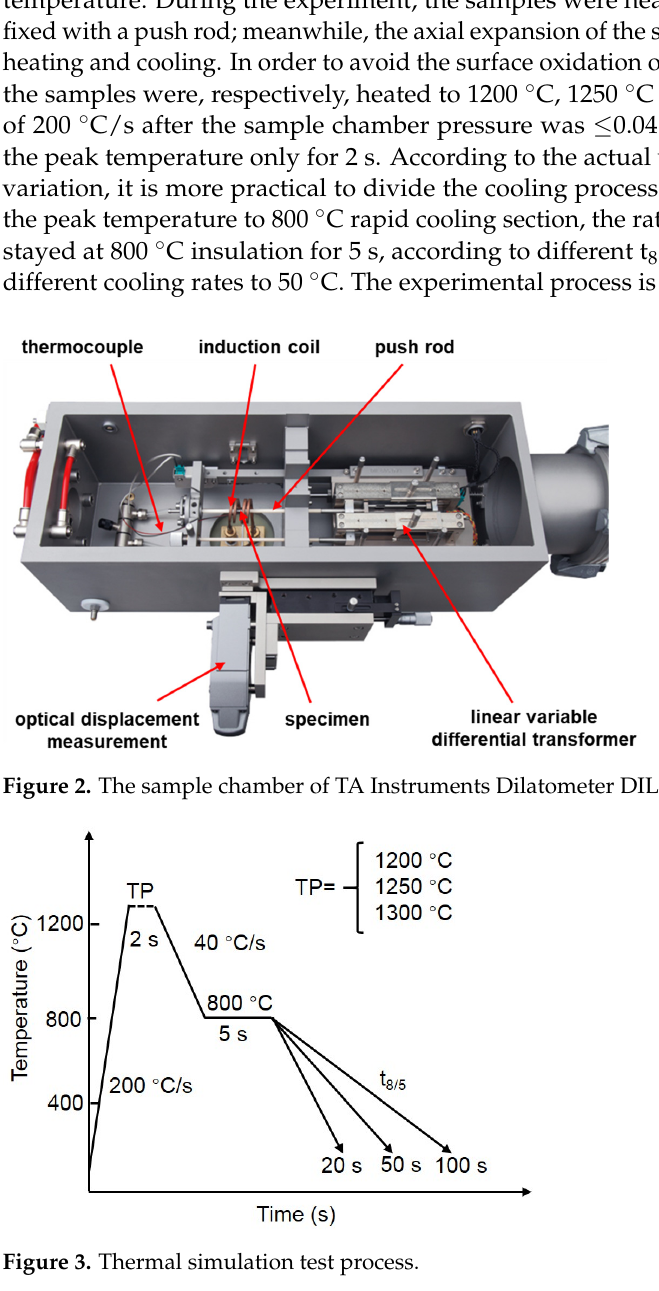
Table 1. Chemical composition of the experimental SA508 Gr.4N steel (mass fraction, %).